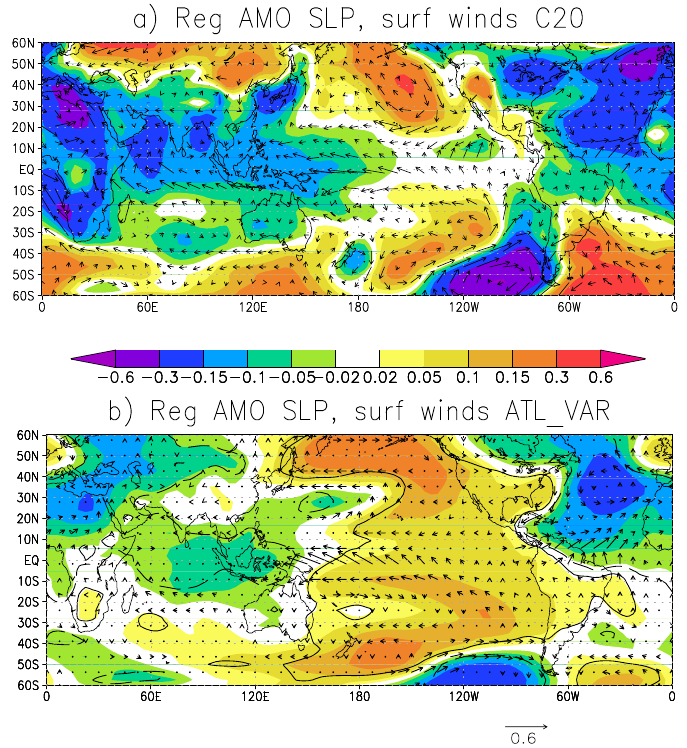
Figure 11. Regression of ( a ) observed and b) ATL_VAR SLP and low-level winds onto preceding AMO index. In ( b ), SLP anomalies that are 95% statistically significant are indicated by contours, and only statistically significant wind vector components are shown. Units are hPa for SLP and m/s for